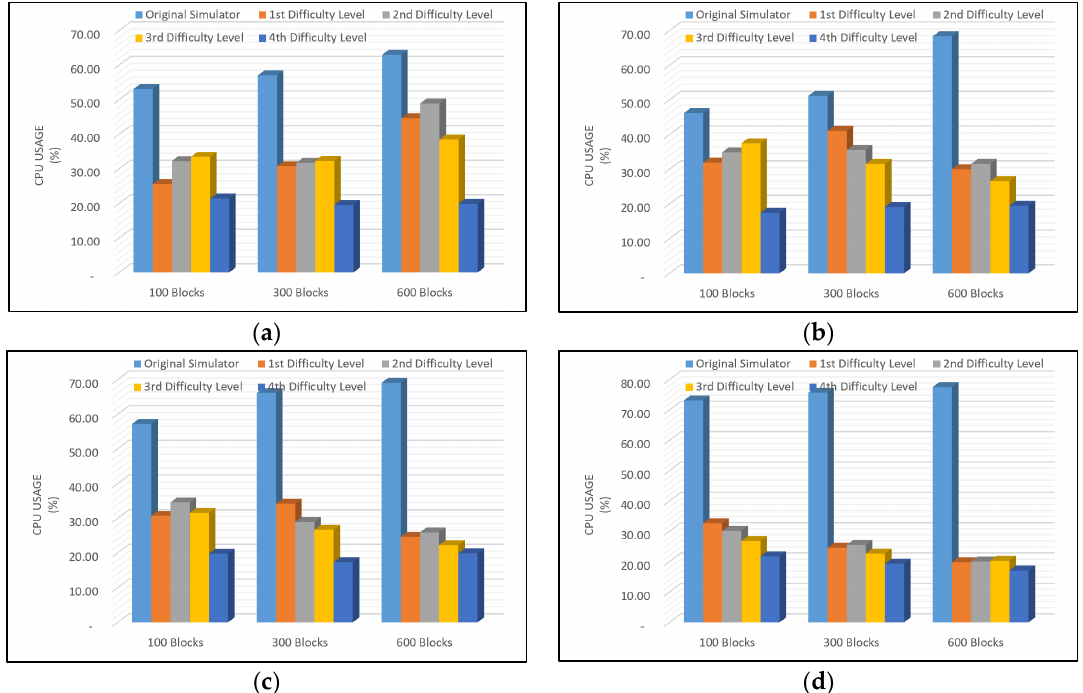
Figure 10. CPU Usage Rate with ( a ) 100 Nodes; ( b ) 300 Nodes; ( c ) 600 Nodes; ( d ) 1000 Nodes.